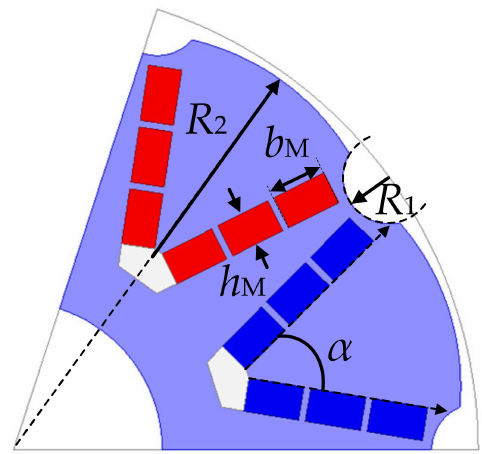
Figure 5. The definition of each parameter in the